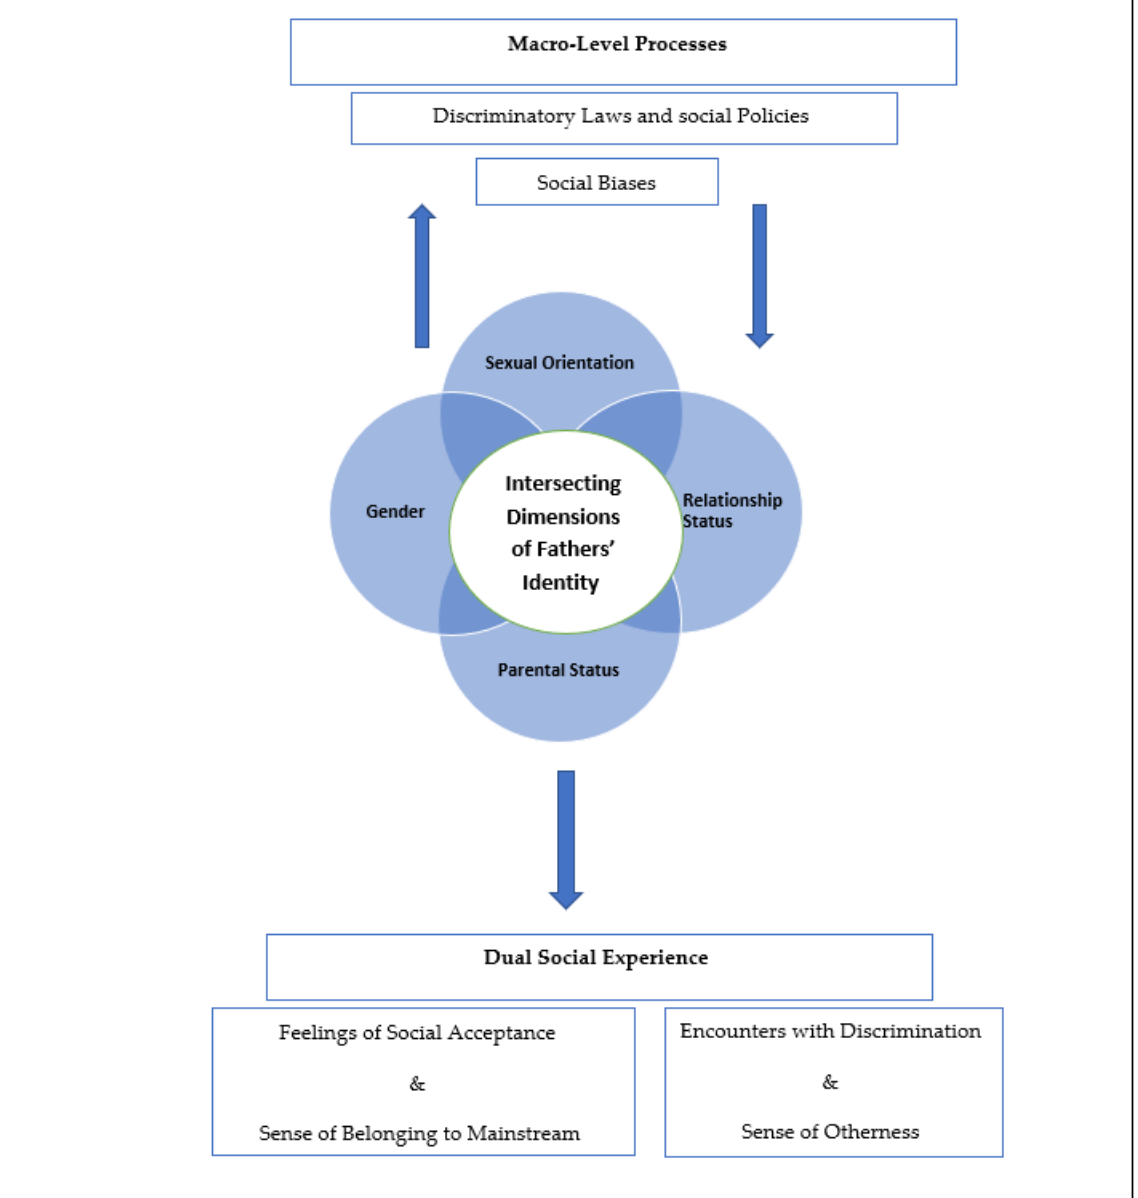
Figure 1. The intersections between multiple dimensions of fathers’ identity and their interaction with macro-level factors.